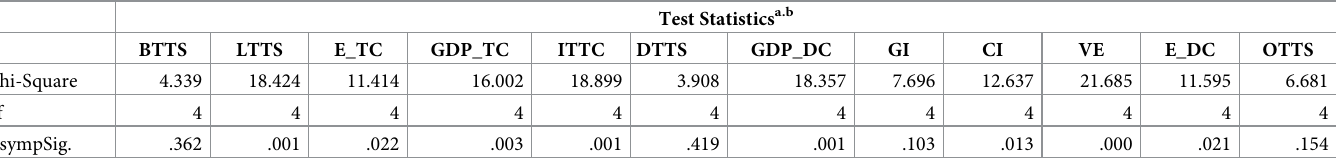
Table 2. Kruskal-Wallis test.